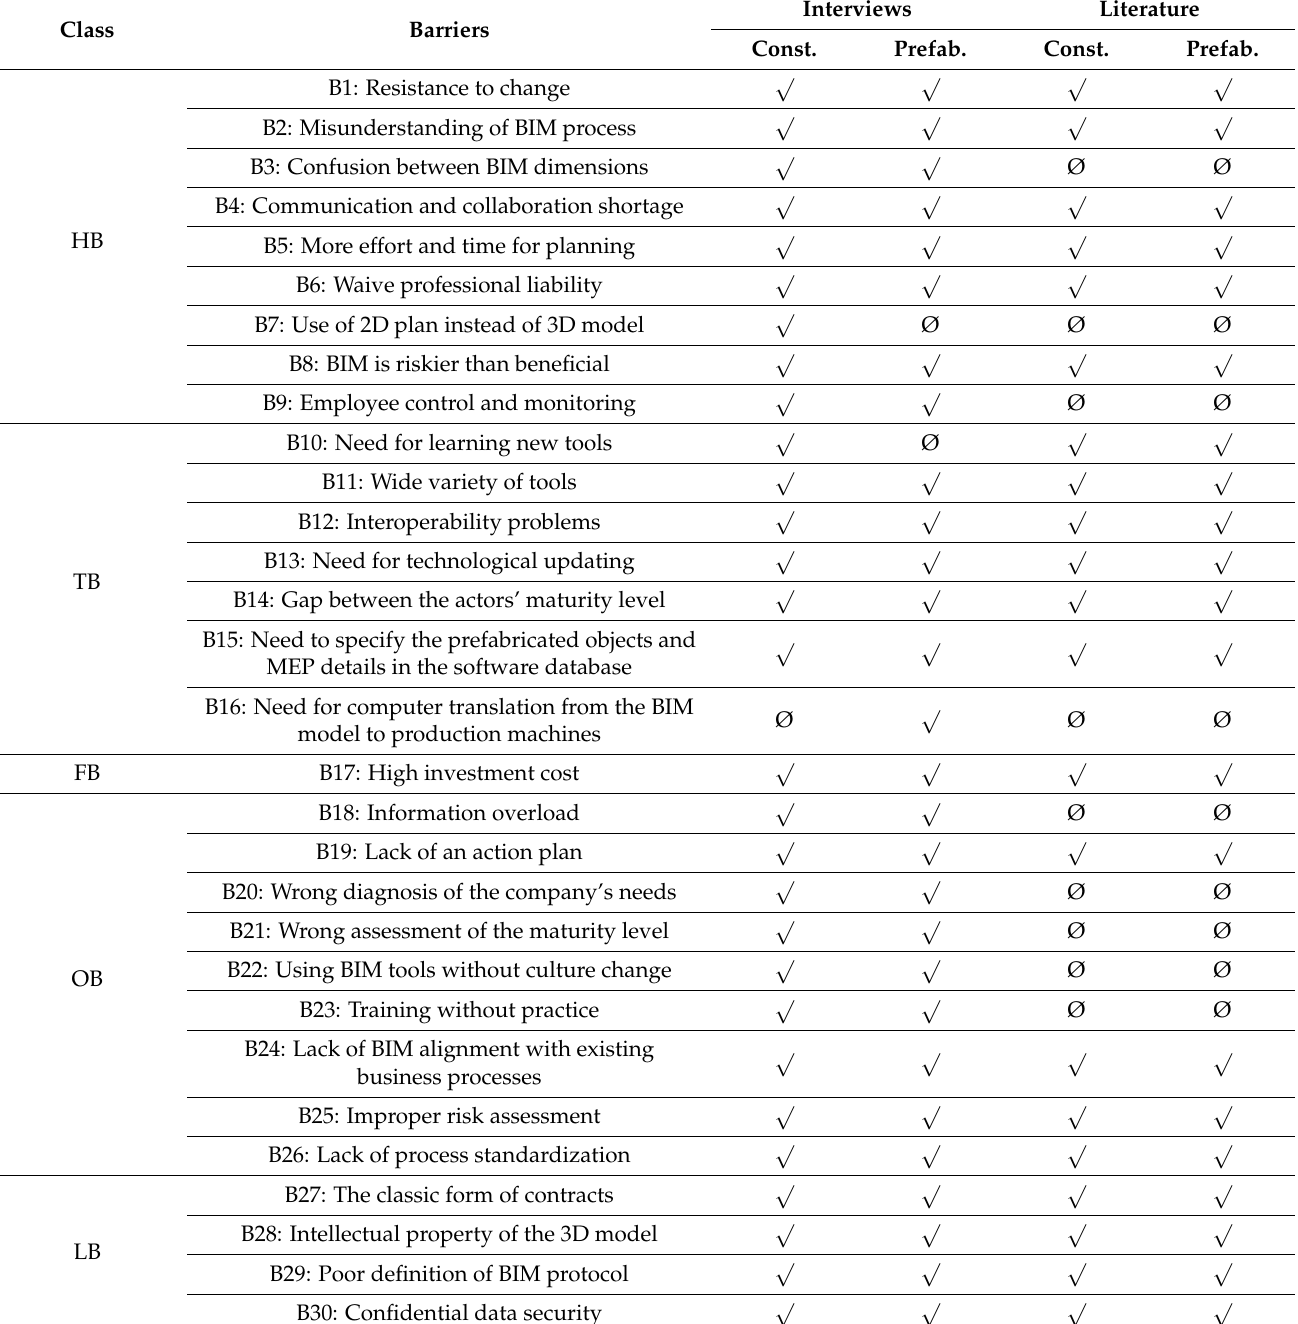
Table 2. BIM barriers in conventional construction and prefabrication sectors. Class Barriers